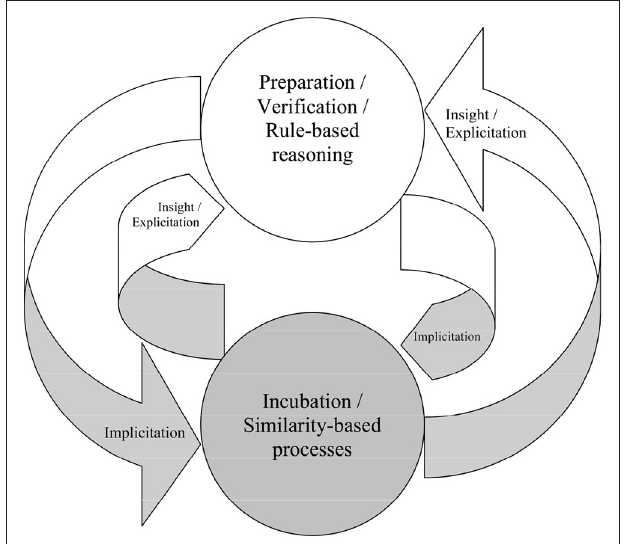
FIGURE 1 | Information flow in the EII theory. The gray sections are implicit while the white sections are